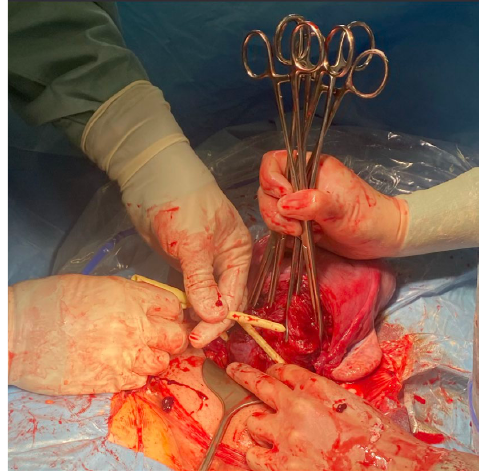
Figure 4. The assistant fixes a sterile Foley cathether “en bloc” around the cervix at the level of the uterosacral ligaments, about 3 – 4 cm below the level of the incision.